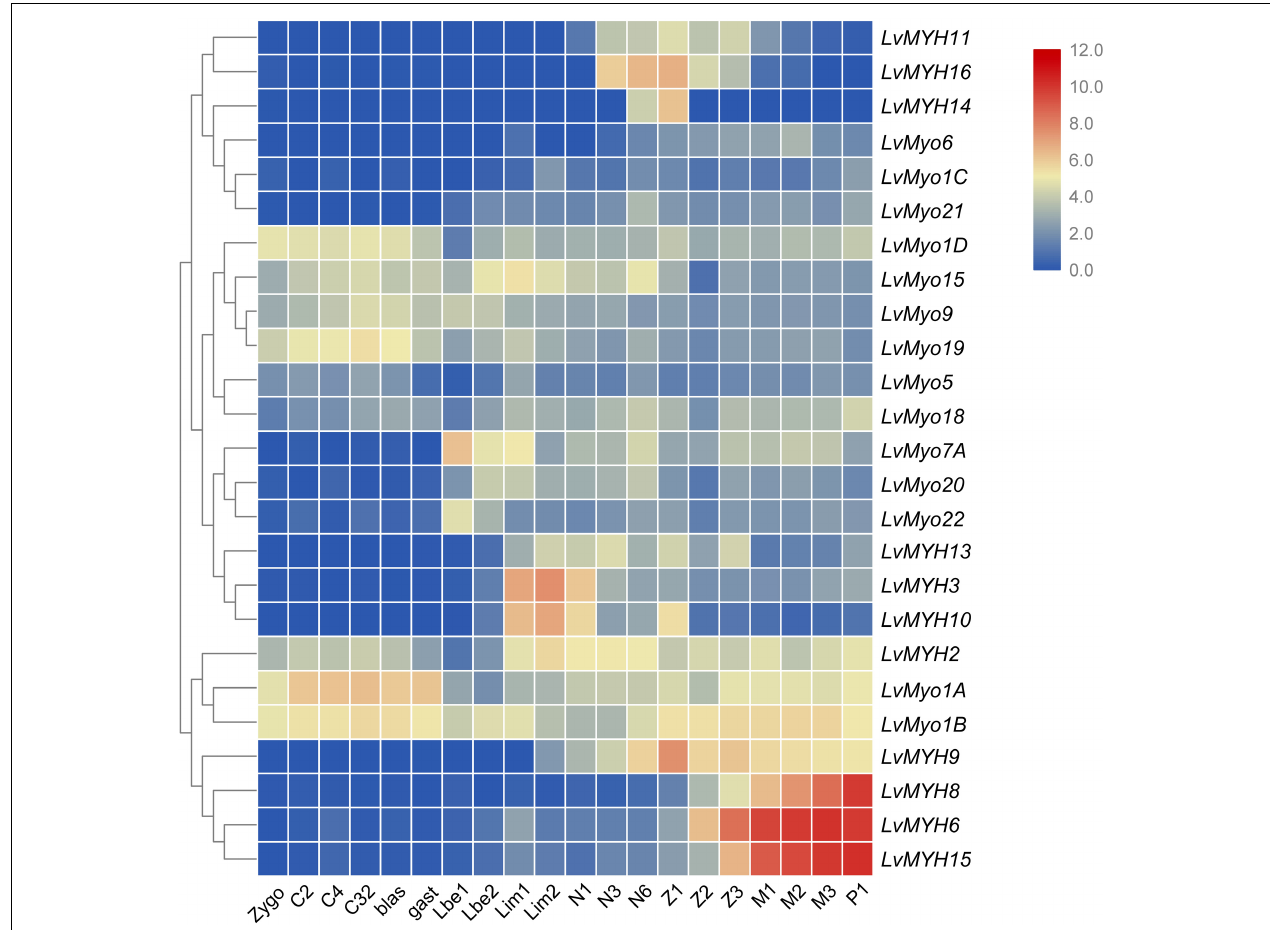
FIGURE 8 | The expression profiles of myosin genes during development of L. vannamei . Log2-transformed expression values were used to create the heat map. The red or blue colors represent the higher or lower relative abundance of each myosin gene, repectively. On the right are myosin genes; the bottom lists different larval stages of L. vannamei , from left to right: zygote, 2 cells (C2), 4 cells (C4), 32 cells (C32), blastula (blas), gastrula (gast), limb bud embryo 1 (Lbe1), limb bud embryo 2 (Lbe2), larva in membrane 1 (Lim1), larva in membrane 2 (Lim2), Nauplius 1 (N1), Nauplius 2 (N2), Nauplius 3 (N3), Nauplius 6 (N6), Zoea 1 (Z1), Zoea 2 (Z2), Zoea 3 (Z3), Mysis 1 (M1), Mysis 2 (M2), Mysis 3 (M3), and Post-larva 1